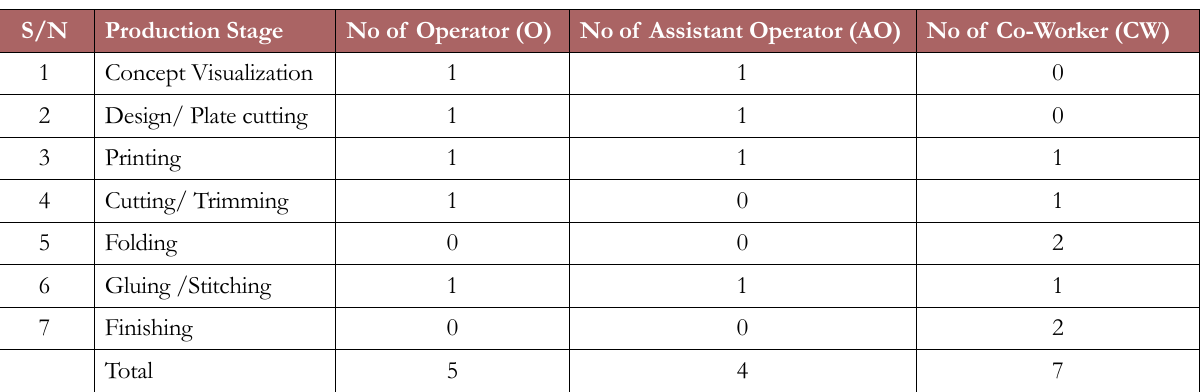
Table 11. Improved Labour of AB Production line